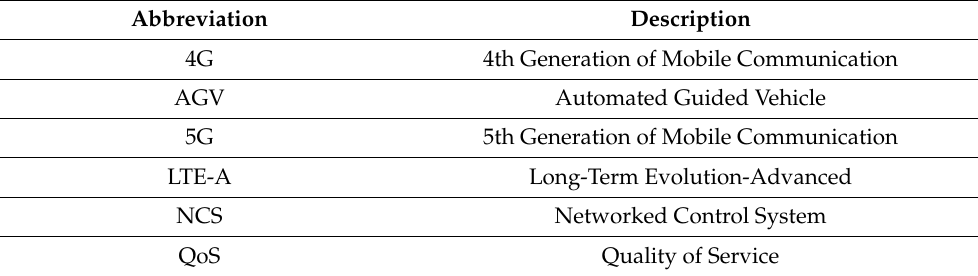
Table A1. List of abbreviations.